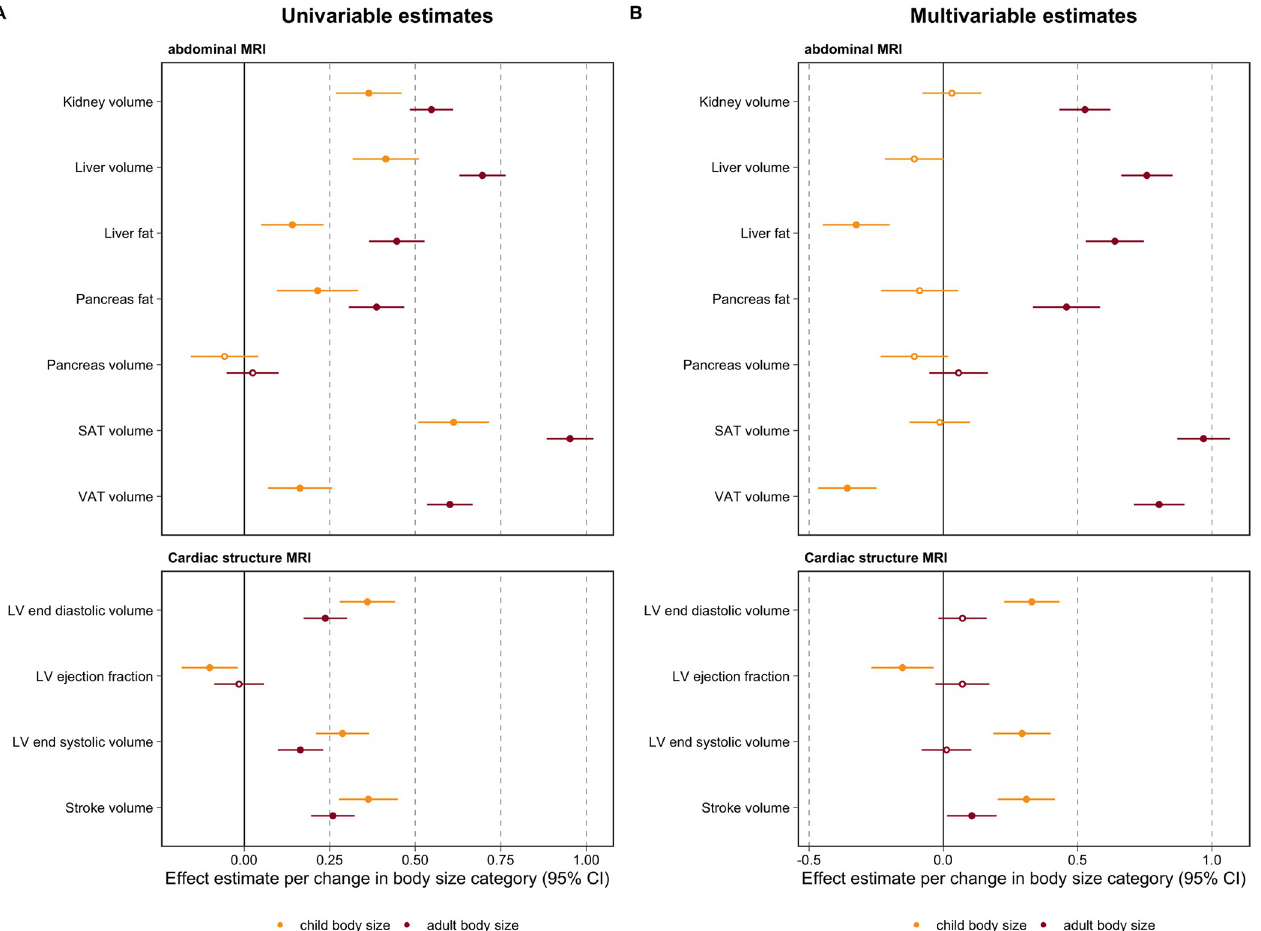
Fig 2. Forest plots illustrating (A) univariable and (B) multivariable MR effect estimates of childhood and adult body size on measures of cardiac structure/function and abdominal organ size/fat percentage. The estimates for child body size are in orange and the estimates for adult body size are in red. The effect estimates are per change in body size category and include the 95% CI. The data underlying this figure can be found in S3, S4, S6, and S7 Tables. CI, confidence interval; LV, left ventricular; MR, mendelian randomization; MRI, magnetic resonance imaging; SAT, subcutaneous adipose tissue; VAT, visceral adiposity